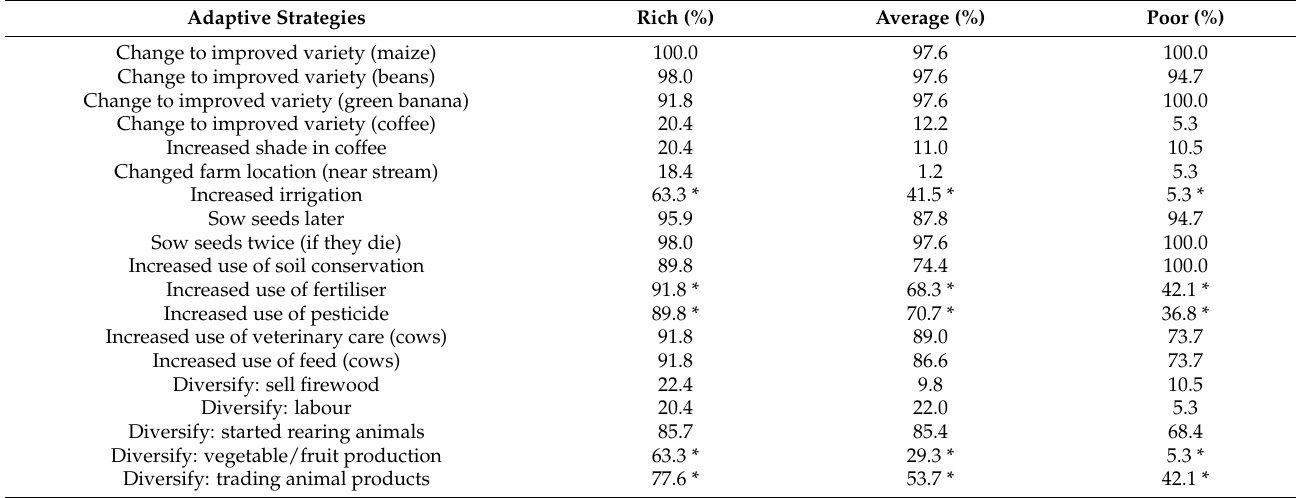
Table 1. Adaptive strategies used by each wealth group on Mount Kilimanjaro (% respondents within wealth group). * Significant differences across wealth groups at p > 0.05, using cross-tabulation tables and chi-square tests. Adaptive Strategies Rich (%) Average (%) Poor (%) Change to improved variety (maize)